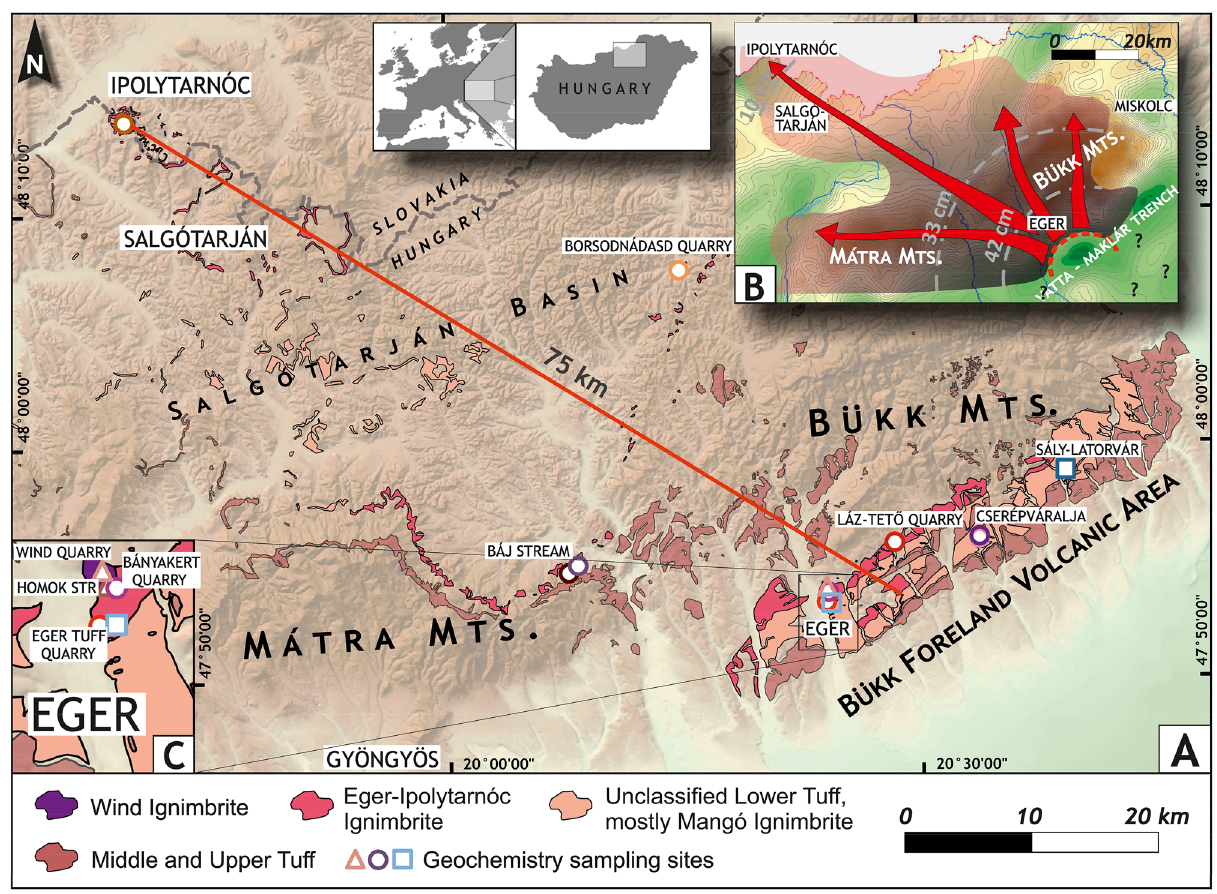
Figure 1. Areal distribution of the main pyroclastic formations: the Lower, Middle and Upper Tuff in the Northern Pannonian Basin (Hungary) draped over a shaded relief image derived from the 50 m DEM of Hungary ( A ). Source of surface occurrences: Mining and Geological Survey of Hungary MBFSZ 1:100,000 geological map (https:// map. mbfsz. gov. hu/). (Image created with Surfer 13, version 13.0.383 Golden Software.) Initiation of the ignimbrite flare-up is represented by the Wind Ignimbrite (confined to Eger Northeast) and the subsequent, widespread Eger-Ipolytarnóc Ignimbrite (the focus of this study). As for the latter, the average distance between the medial Eger occurrences and the distal Ipolytarnóc site is c. 75 km (red line). Inset map top right ( B ) shows the possible distribution of the first-phase pyroclastic surge and the late-stage pumiceous pyroclastic flow from the Eger-Ipolytarnóc eruption, draped over the Bouguer gravity anomaly map of Hungary (MBFSZ 1:500,000). Possible isopach lines of the third-phase pumice-fall deposits of the eruption, based on three sites (see main text), are also indicated. A marked negative gravity anomaly southeast of Eger town, as part of the Vatta-Maklár trench, is in accordance with a potential caldera as source vent 6 . Inset map bottom left ( C ) shows a close-up of the vicinity of Eger with locations mentioned in